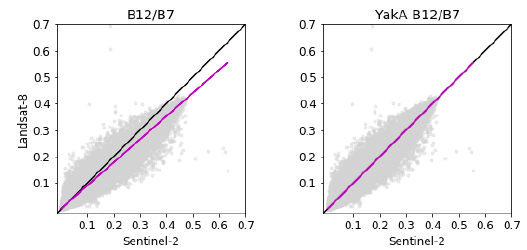
Figure A2. Comparison of surface reflectance values from the Sentinel-2 and Landsat-8 corresponding bands for Yakutsk. Left plots: observed surface reflectance values. Right plots: Yakutsk Adjusted (YukA) Sentinel-2 reflectance values. The solid black line is one-to-one, and the pink line is the ordinary least squares regression trend